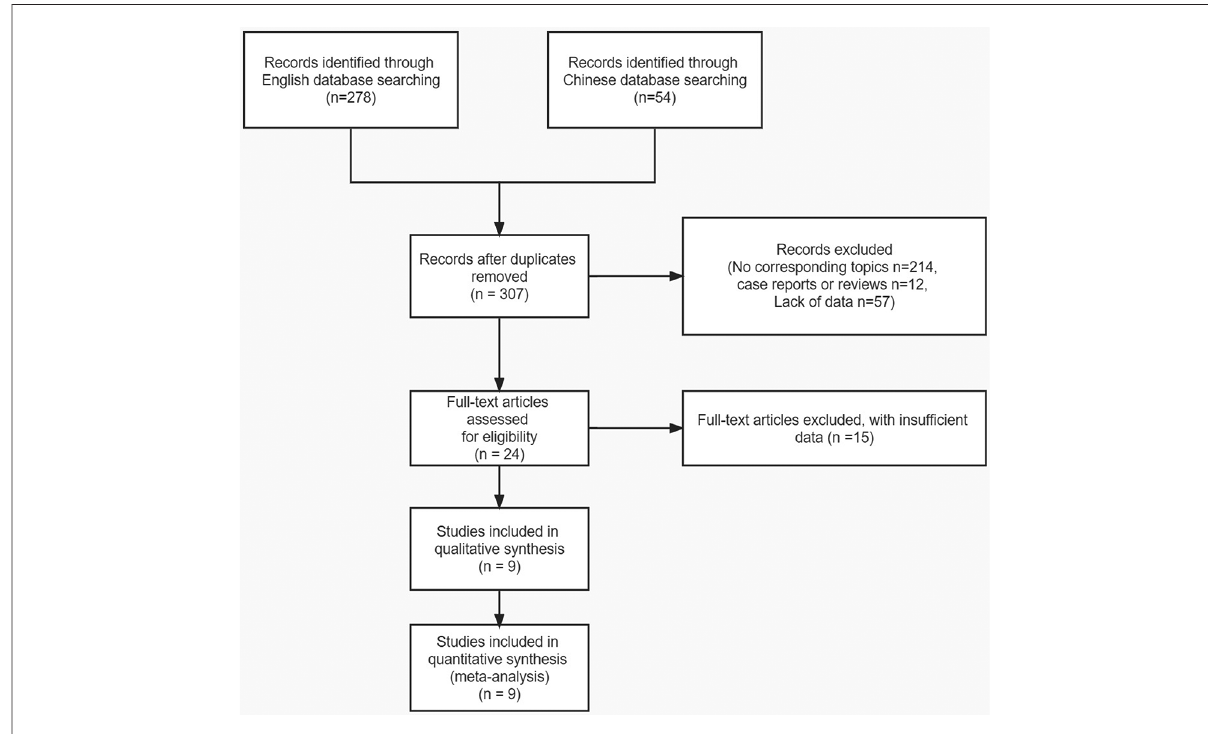
FIGURE 1 Flow diagram of the literature selection